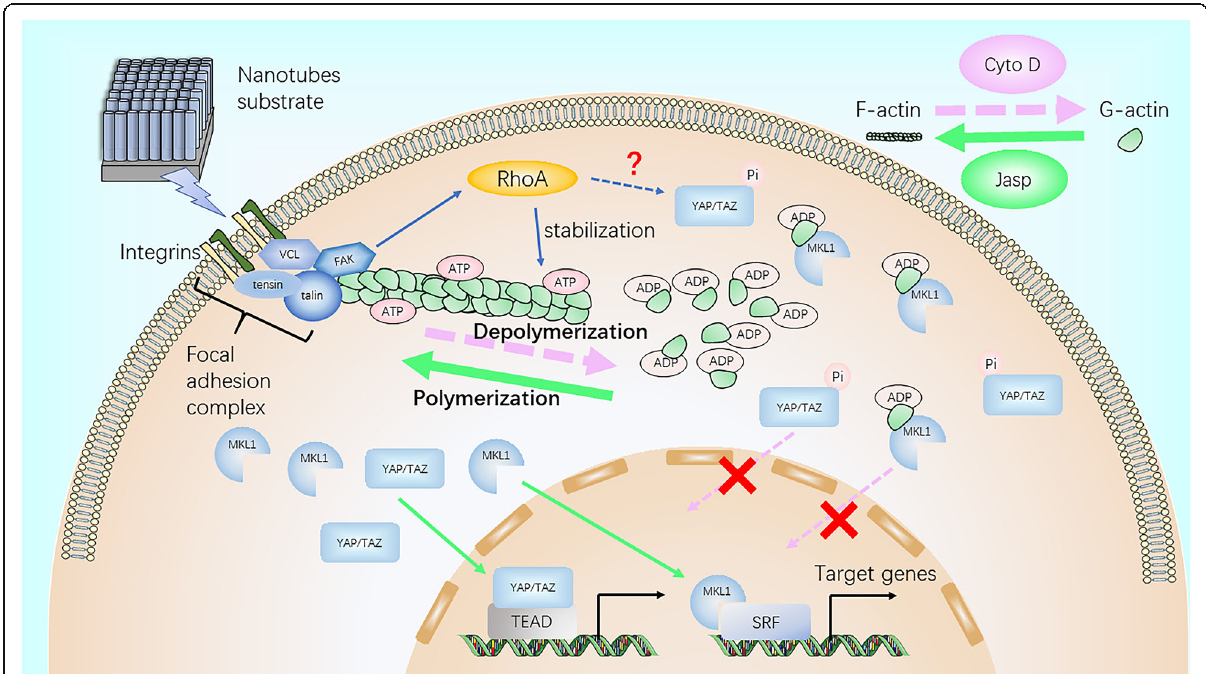
Fig. 7 Schematic representation of F-actin assembly induced by nanotubes, and the putative role of MKL1 and YAP/TAZ in acting as the downstream mediators of F-actin signaling to regulate gene